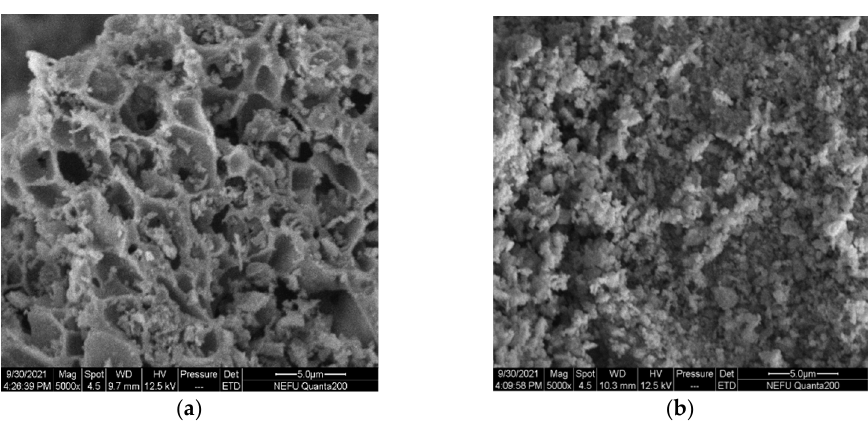
Figure 10. SEM of catalyst samples: ( a ) La 0.8 Ce 0.2 CoO 3 ; and ( b ) La 0.8 Ca 0.2 CoO 3 .